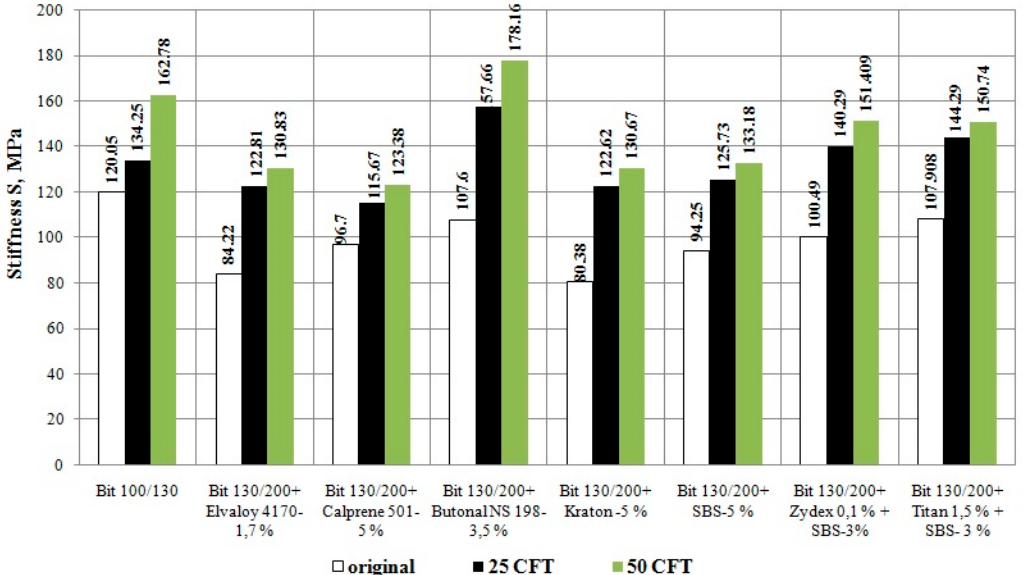
Figure 13. Bitumens stiffness at the temperature of –24° С .